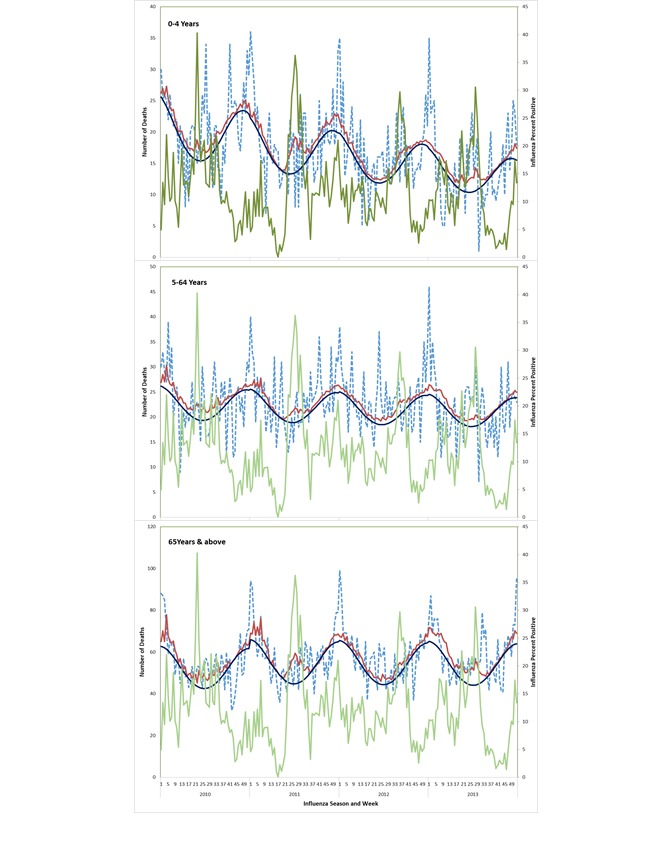
Observed respiratory deaths and predicted inﬂuenza-associated respiratory deaths and proportion positive for influenza viruses by age group, week, and year. The dotted blue line represents respiratory deaths, the green line represents influenza percent positive, the dark blue line represents expected baseline mortality, and the red line represents predicted mortality. The number of excess influenza-associated deaths are the difference between the orange and red lines